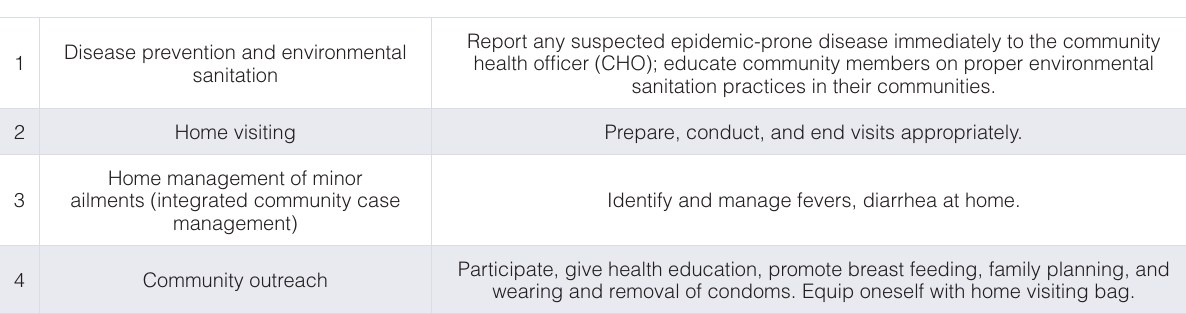
Table 2. Roles and responsibilities of Community Health Volunteers (CHVs) 8 .